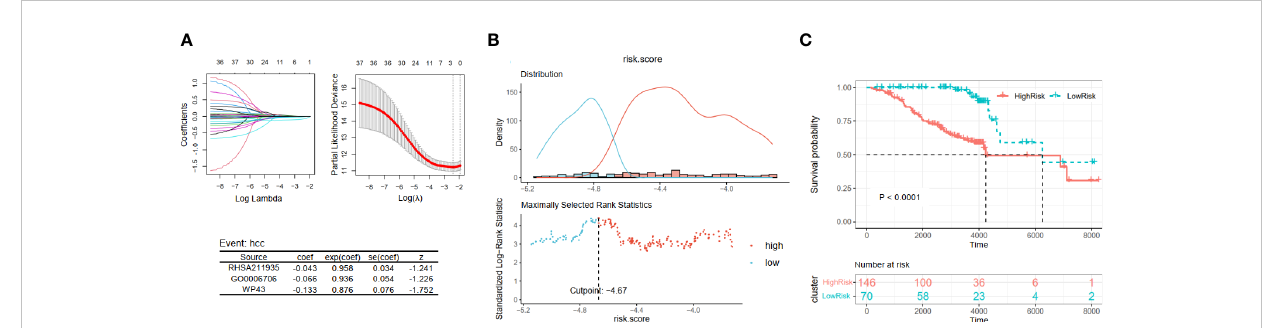
FIGURE 4 Construction and validation of viral hepatitis cancerization risk-related models. (A) The LASSO regression model is visualized. (B) According to the cut point with maximally selected rank statistics, the patients were split into high-risk and low-risk groups. (C) Kaplan – Meier plots of survival curve between two subgroups. LASSO, least absolute shrinkage and selection